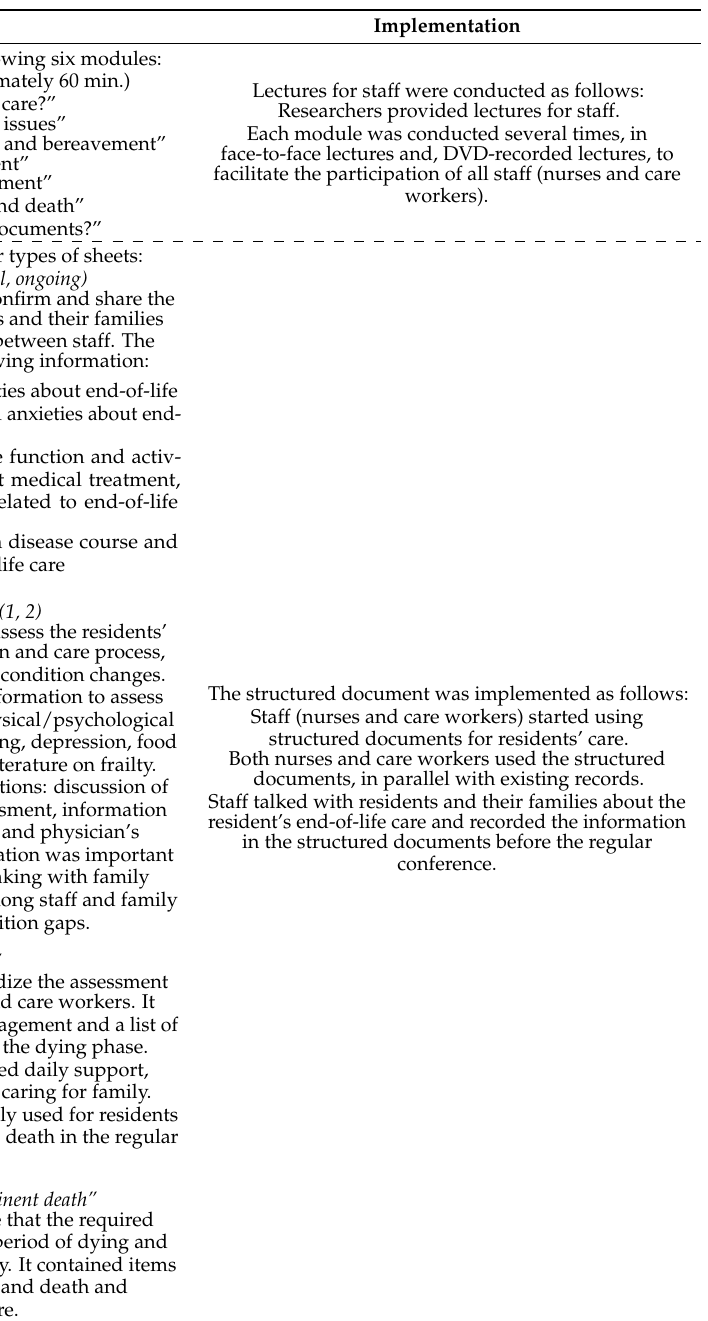
Table 1. Components of the EOL Care